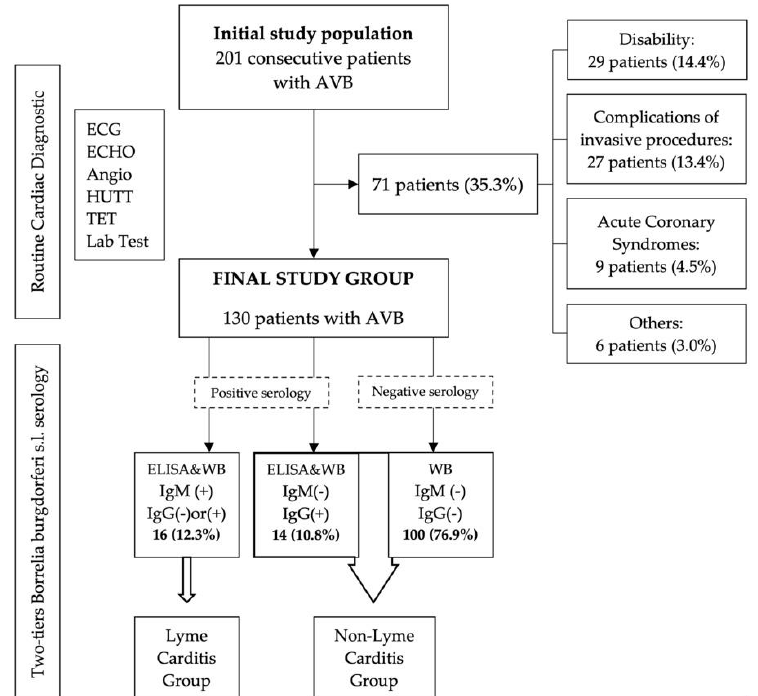
Figure 1. The workflow of the study. Figure legend. AVB — atrioventricular block; ECG — electrocar- diogram, ECHO — echocardiography; Angio — coronary or/and pulmonary angiography; HUTT — head-up tilt test; TET — treadmill exercise test; Lab Test — laboratory tests; s.l. — sensu lato; ELISA — enzyme immunoassay test; WB — immunoblot test; IgM/IgG — i mmunoglobulin class M/G; (−) neg- ative; (+) positive.